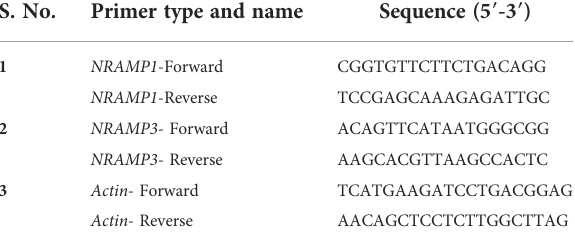
TABLE 2 List of primers used to study the expression of NRAMP genes through real-time PCR. S.